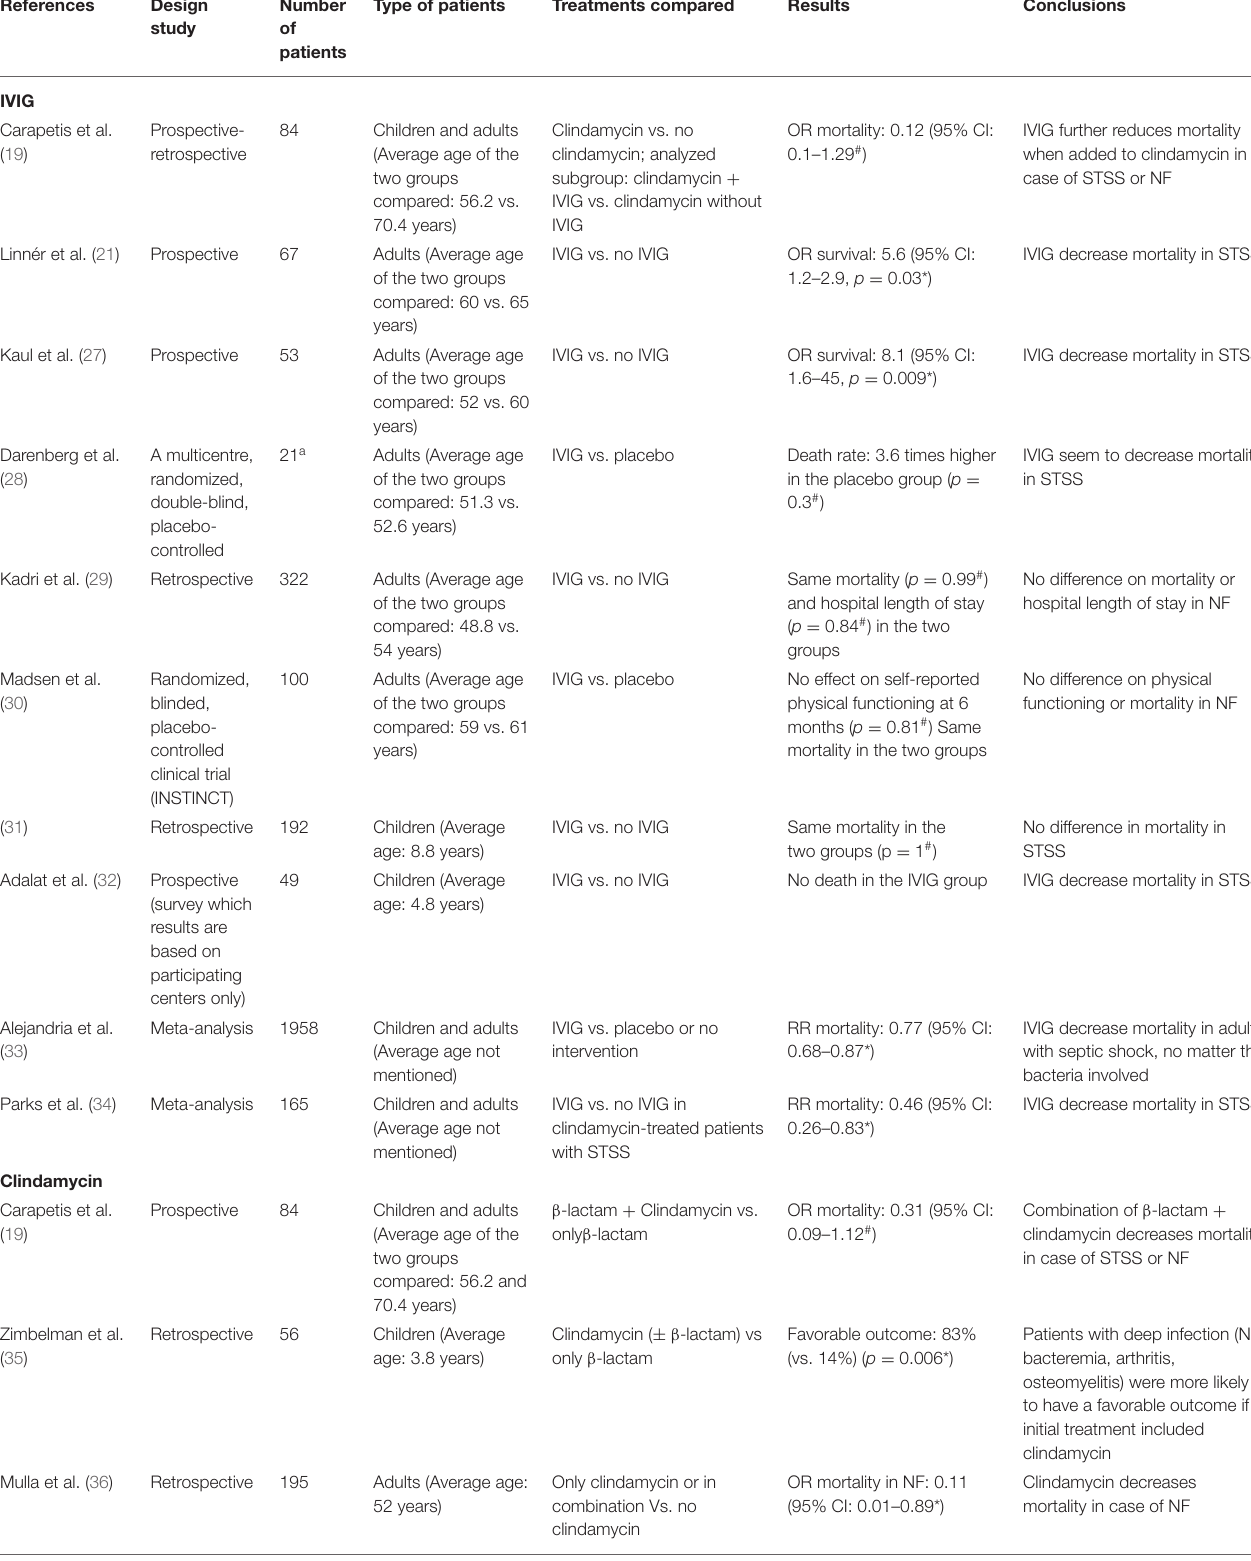
TABLE 2 | Studies assessing the clinical efficacy of IVIG and clindamycin in